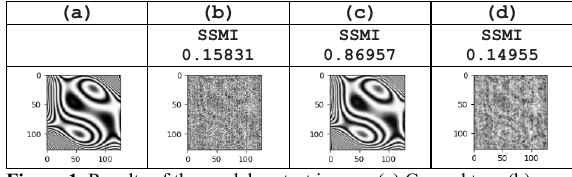
Figure 1. Results of the model on test images.(a) Ground true;(b) Noisy image; (c) Denoised image with trained model; (d) Denoised image using a Median Filter with 3x3